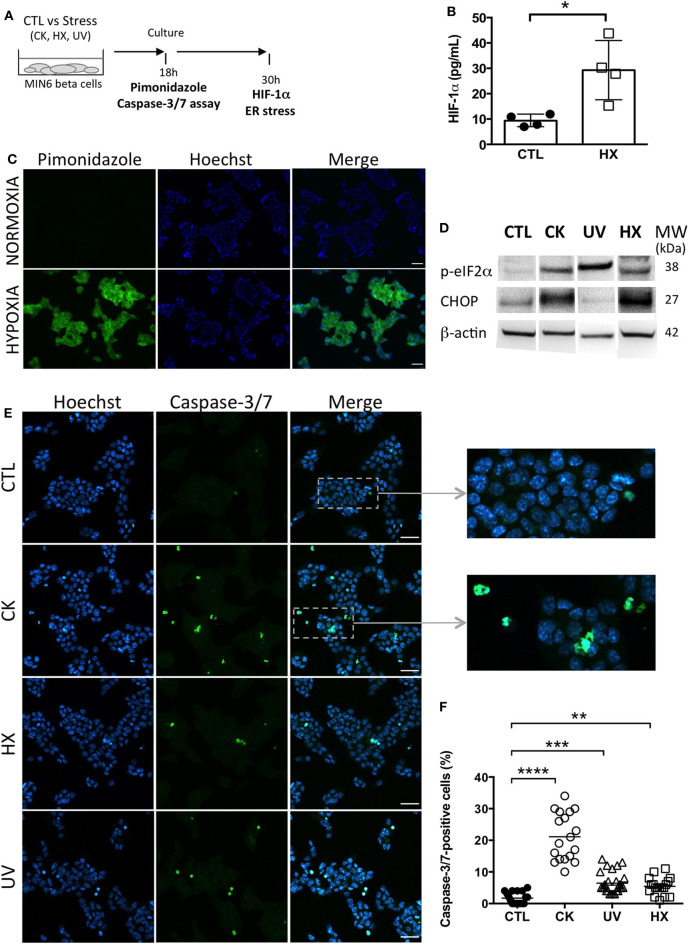
Experimental beta cell stress induces apoptosis. (A) After exposure to stress [TNFα, IL-1β, IFN-γ cytokines; CK], hypoxia (HX), ultraviolet (UV)] or not [control (CTL)], MIN6 cells were cultured in 1% FCS exosome-depleted OptiMEM medium. (B,C) For cultures grown under normoxic and hypoxic conditions, (B) After 24 h of culture, MIN6 cells were treated with 100 μM pimonidazole and incubated for 2 h followed by immunohistochemical detection of pimonidazole adducts (green). Nuclei were counterstained with Hoechst 33342 (blue). Scalebar 30 μm. Representative images of one out of three independent experiments are shown. (C) ELISA of the expression of HIF-1α in cells grown under normoxia or hypoxia for 30 h. Data from 4 independent experiments are depicted with median and range. Mann-Whitney test, one-tailed, *p < 0.05. (D) After 30 h of culture, expression of markers of ER stress p-eIF2α and CHOP was analyzed by western blotting and then the membranes were reprobed to β-actin. (E,F) After 18 h of culture, the cells were stained with CellEvent Caspase-3/7 reagent (green) or Hoechst 33342 (nucleic dye, blue). (E) Fluorescence microscopy images of MIN6 cells reveal cells undergoing apoptosis as shown by the presence of caspase-3/7- positive cells. Scale bar 30 μm. (F) The quantitative analysis showed a significant increase in the percentage of caspase-positive cells for treated in comparison to untreated control cells. Each data point represents results obtained for one image. Data are compiled from n = 18 images (> 8,000 nuclei) per situation from two independent experiments. Kruskal–Wallis test (**p < 0.01, ***p < 0.001 and ****p < 0.0001).